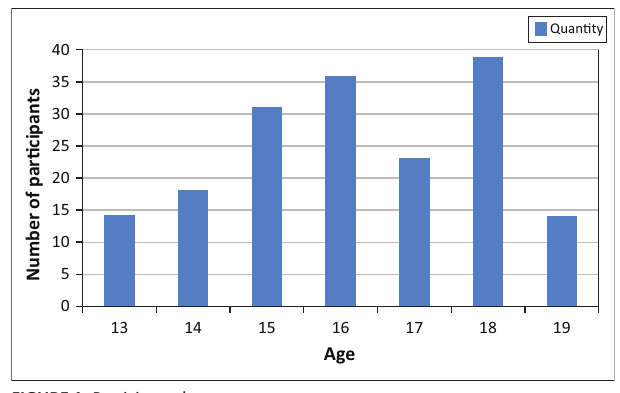
FIGURE 1: Participants’ age.